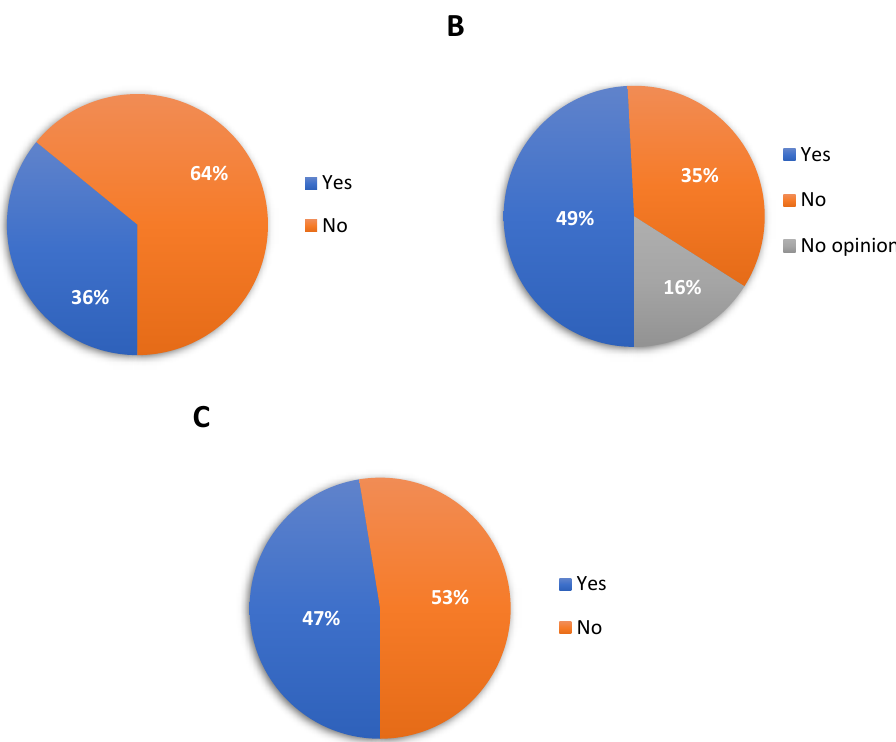
Figure 2. Health habits of patients. ( A ) Taking drugs in chronic disease, ( B ) Worsening access to a doctor during a pandemic, ( C ) Performing preventive laboratory diagnostics.